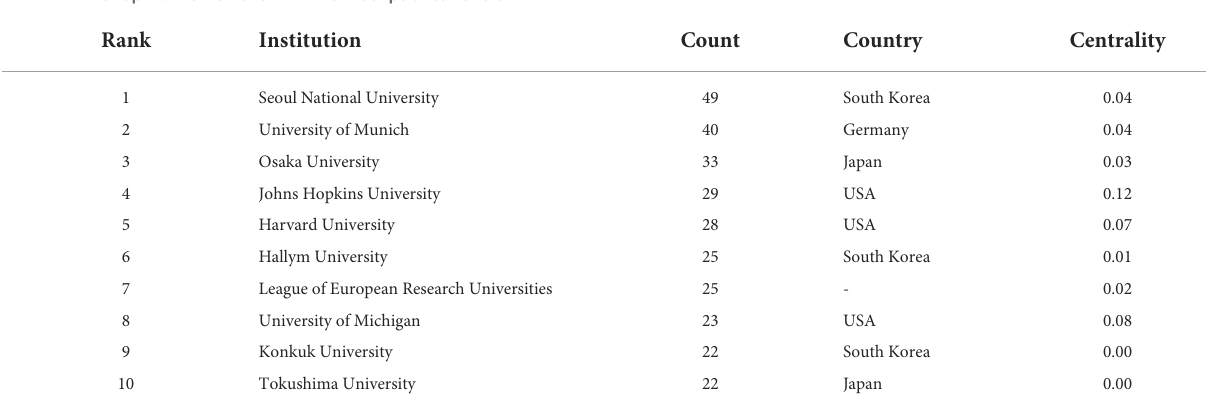
TABLE 2 The top-10 institutions with the most publications on